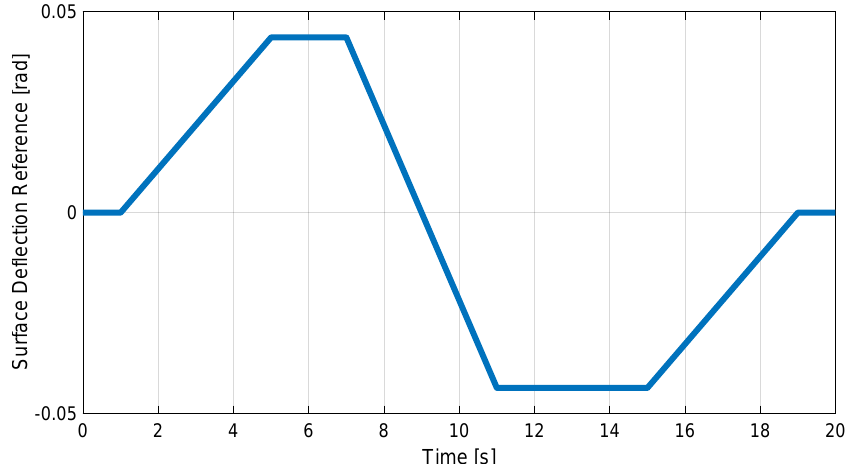
Figure 18. Simulation #3: Surface Deflection Reference.